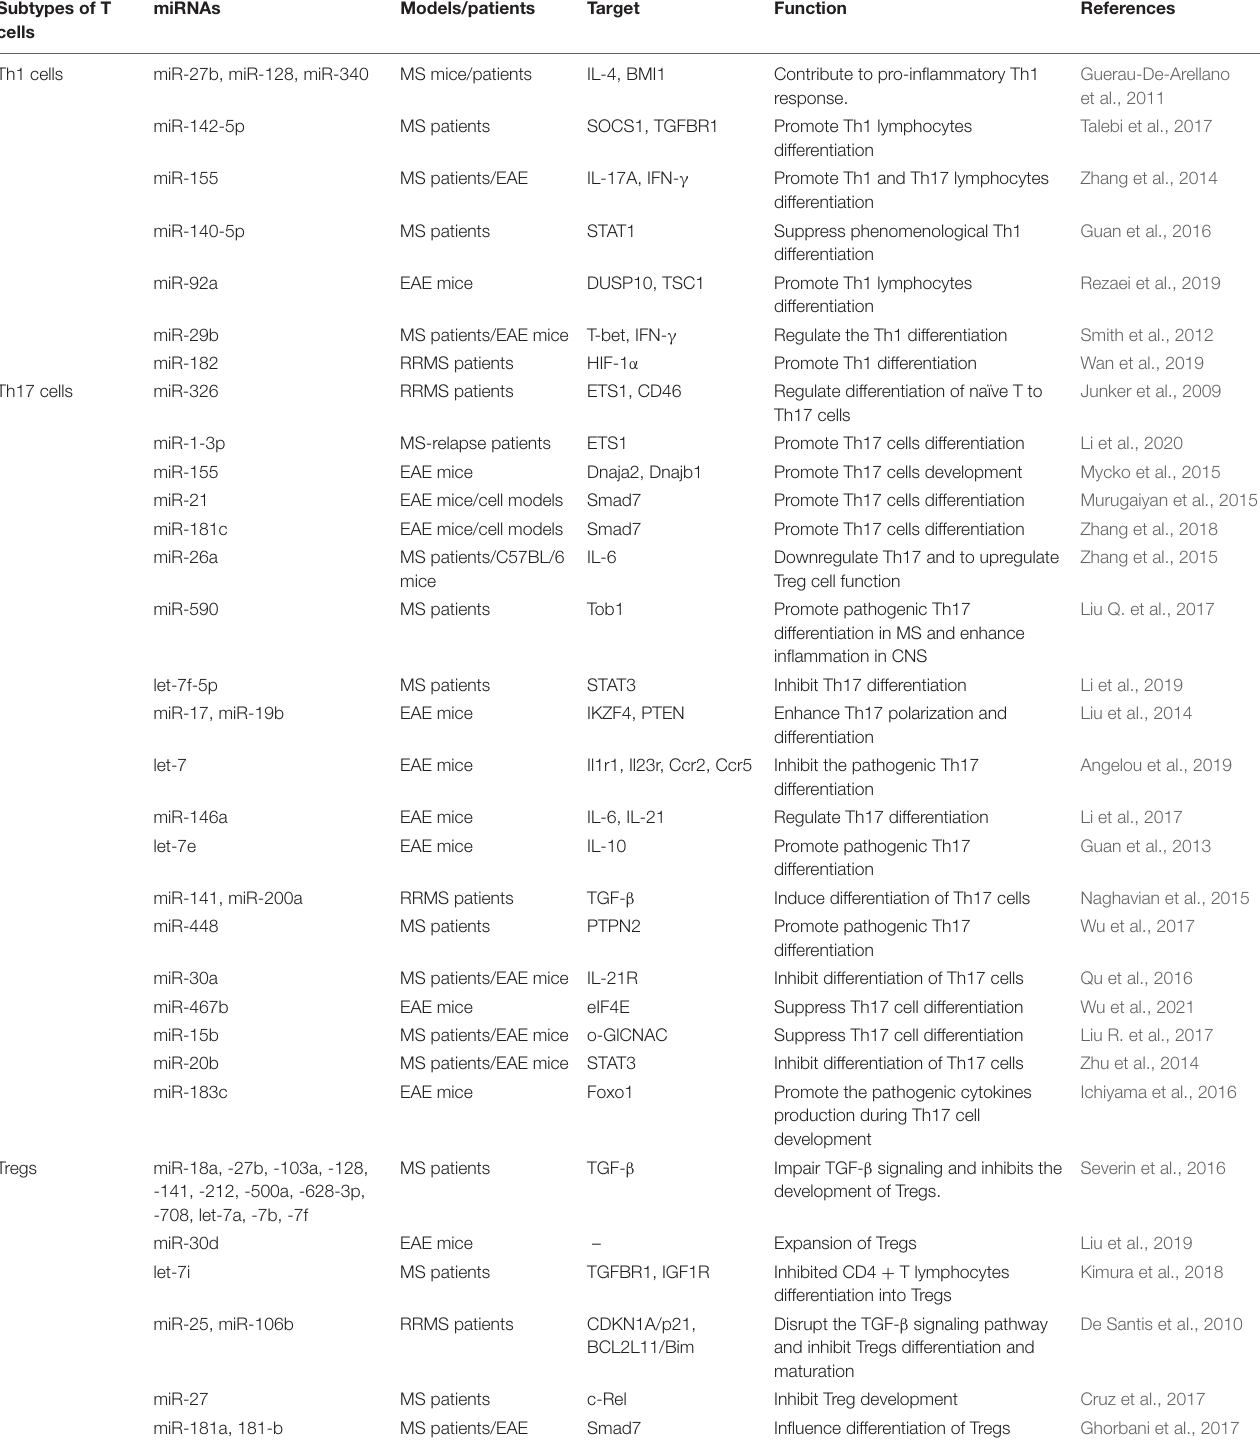
TABLE 1 | Dysregulation of miRNAs in T sub-typing cells of multiple sclerosis. Subtypes of T